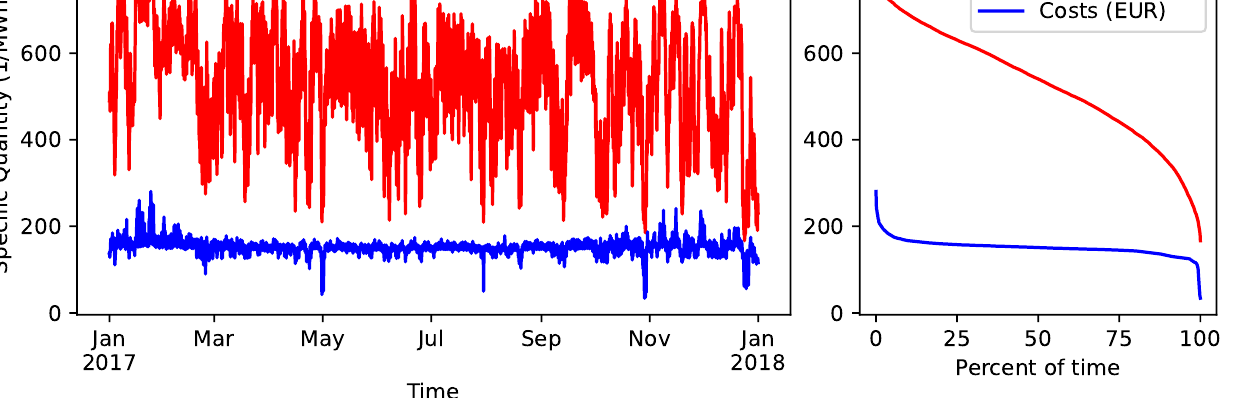
( a ) Data for grid electricity (Flow 1 in Figure 3)